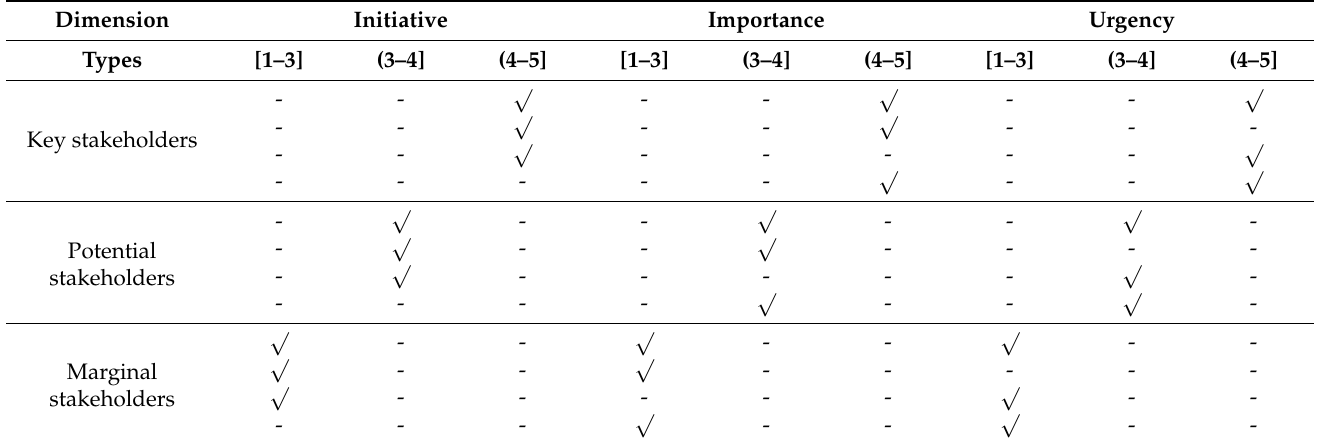
Table 3. WEEE internet recycling industry stakeholder